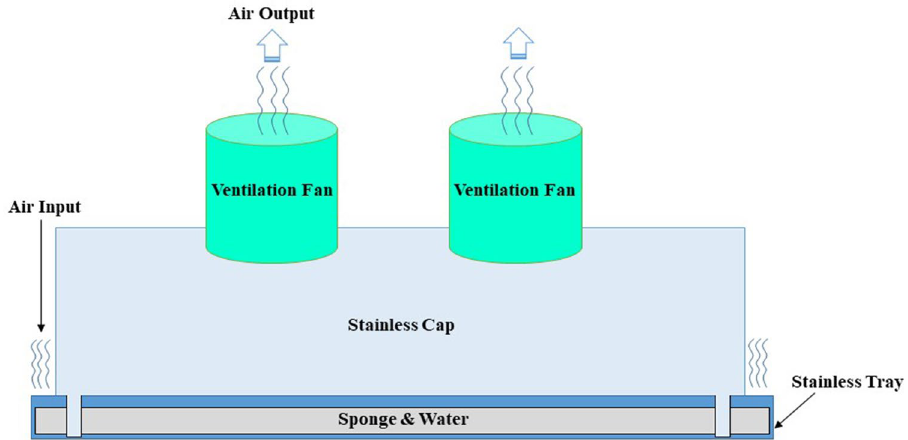
Fig. 3 Working method of water-based air purifier pro-